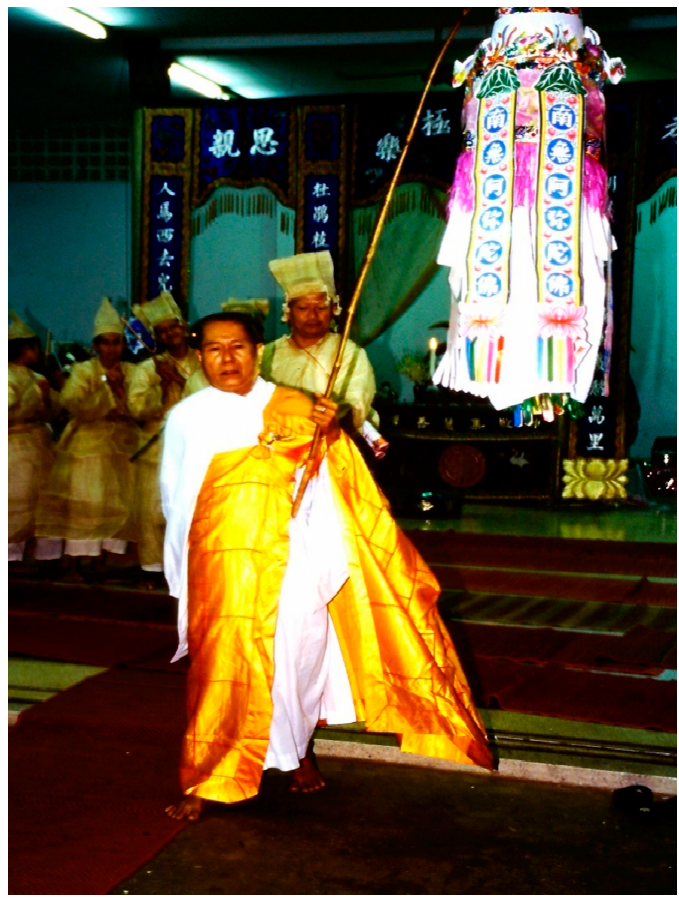
Figure 2. A Daoist priest guiding the soul of the deceased during a g ō ng dé ritual, Thailand, 1994 (© B. Formoso).